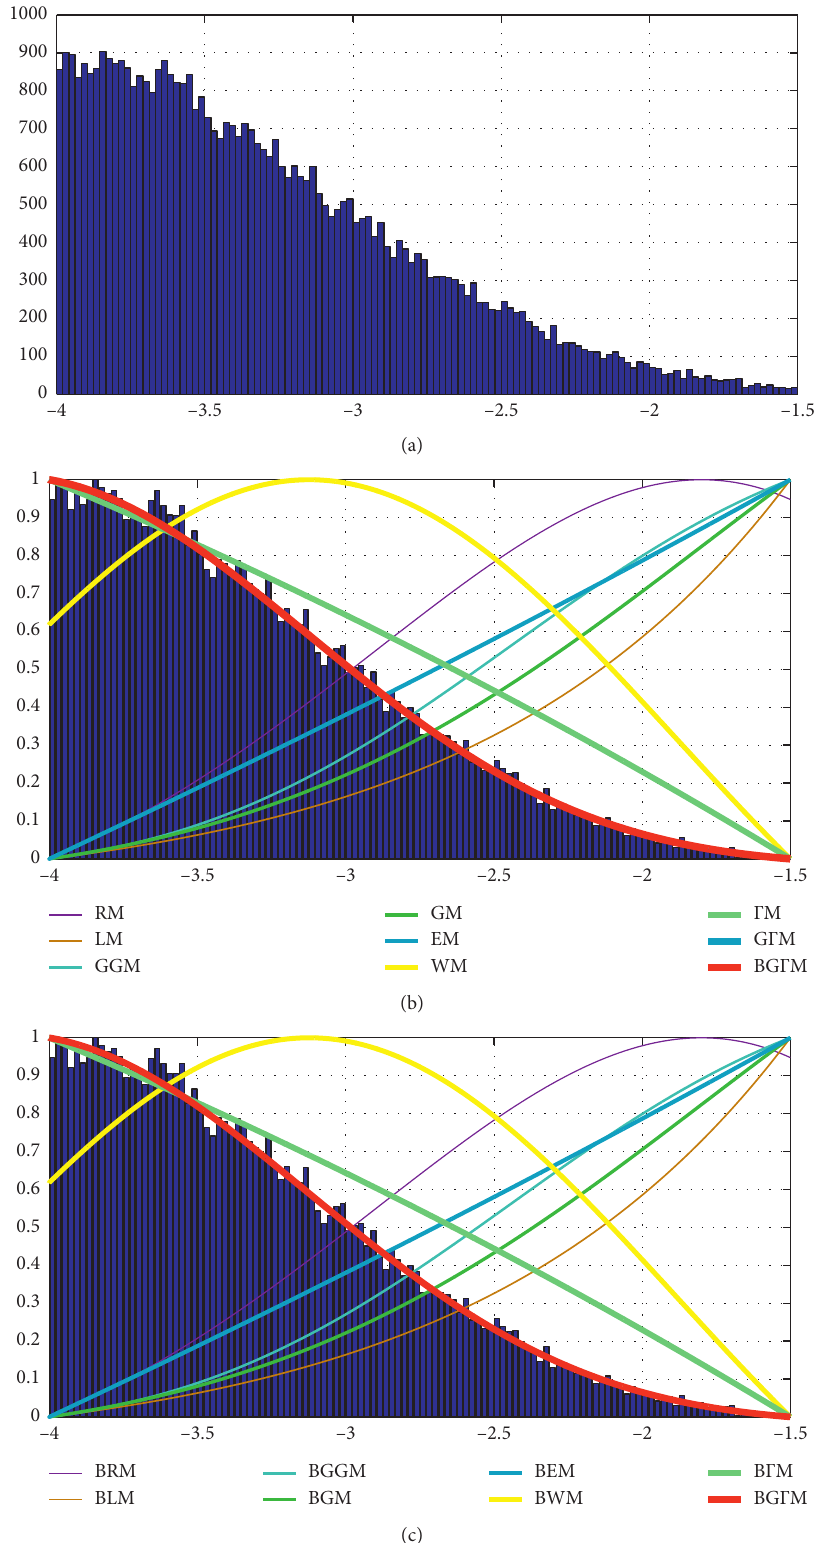
Figure 6: The estimated histogram. (a) The histogram of the observed data with u � − 0 . 3; δ � 1 . 5; η � 2, λ � 3 and β � 0 . 1 in the interval (− 4 , − 1 . 5 ) ; (b) the estimated histogram of RM, LM, WM, GM, EM, GGM, Γ M, G Γ M, and G Γ M; (c) the estimated histogram of BRM, BLM, BWM, BGM, BEM, BGGM, B Γ M, and BG Γ